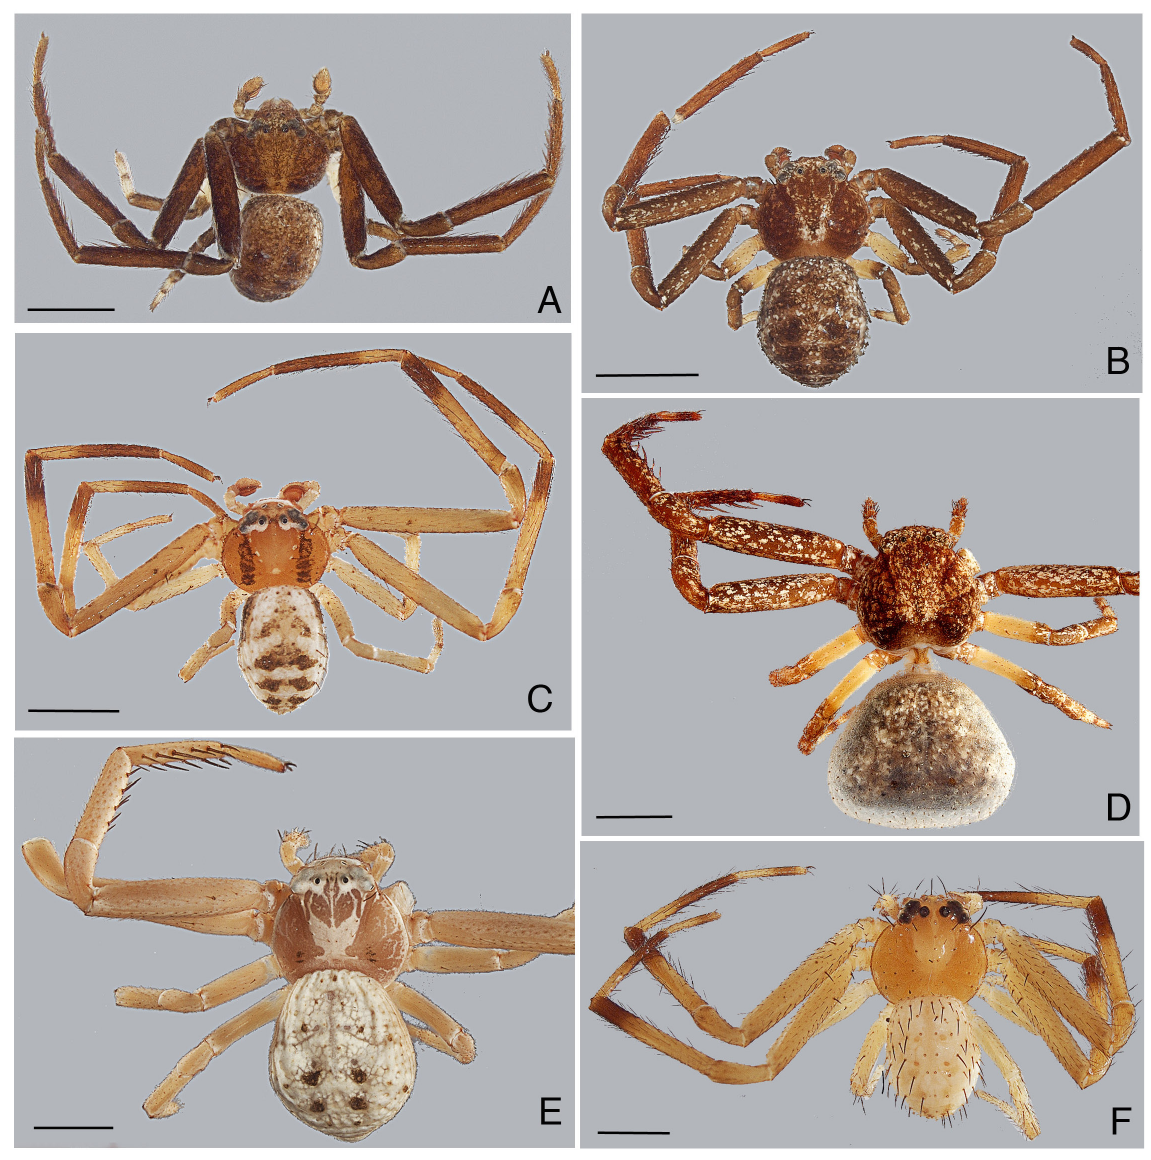
Fig. 9. Habitus. — A-D . Mecaphesa inclusa (Banks, 1902). A . ♂ colour type A. B . ♂ colour type B. C . ♂ colour type C. D . ♀ colour type C. — E-F . Mecaphesa reddelli sp. nov. E . ♀ of Volcán Alcedo (Isla Isabela). F . ♂ of Volcán Alcedo (Isla Isabela). Scale bars: 1 mm. Photographs by Rudy